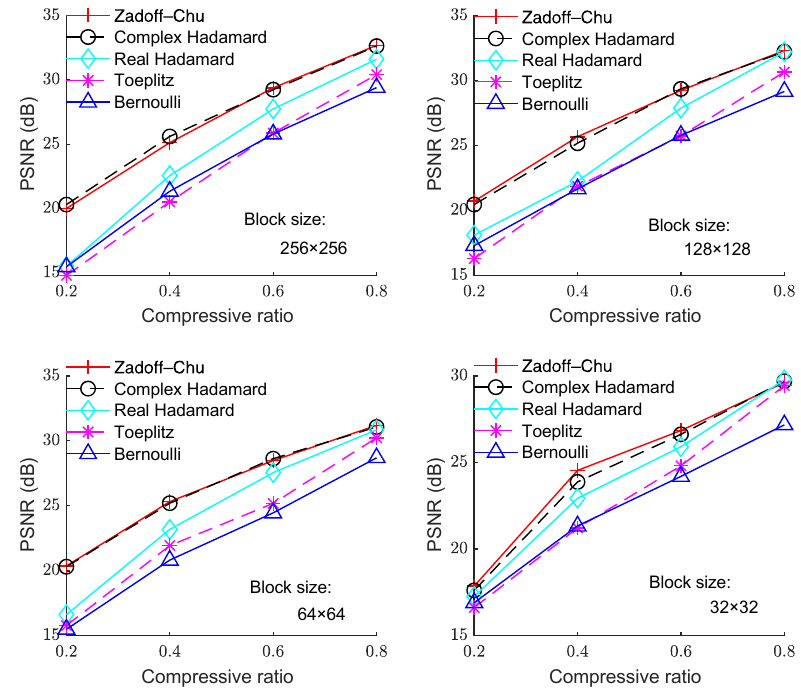
Figure 3. PSNR with CR under different block sizes for the “Boats” image.